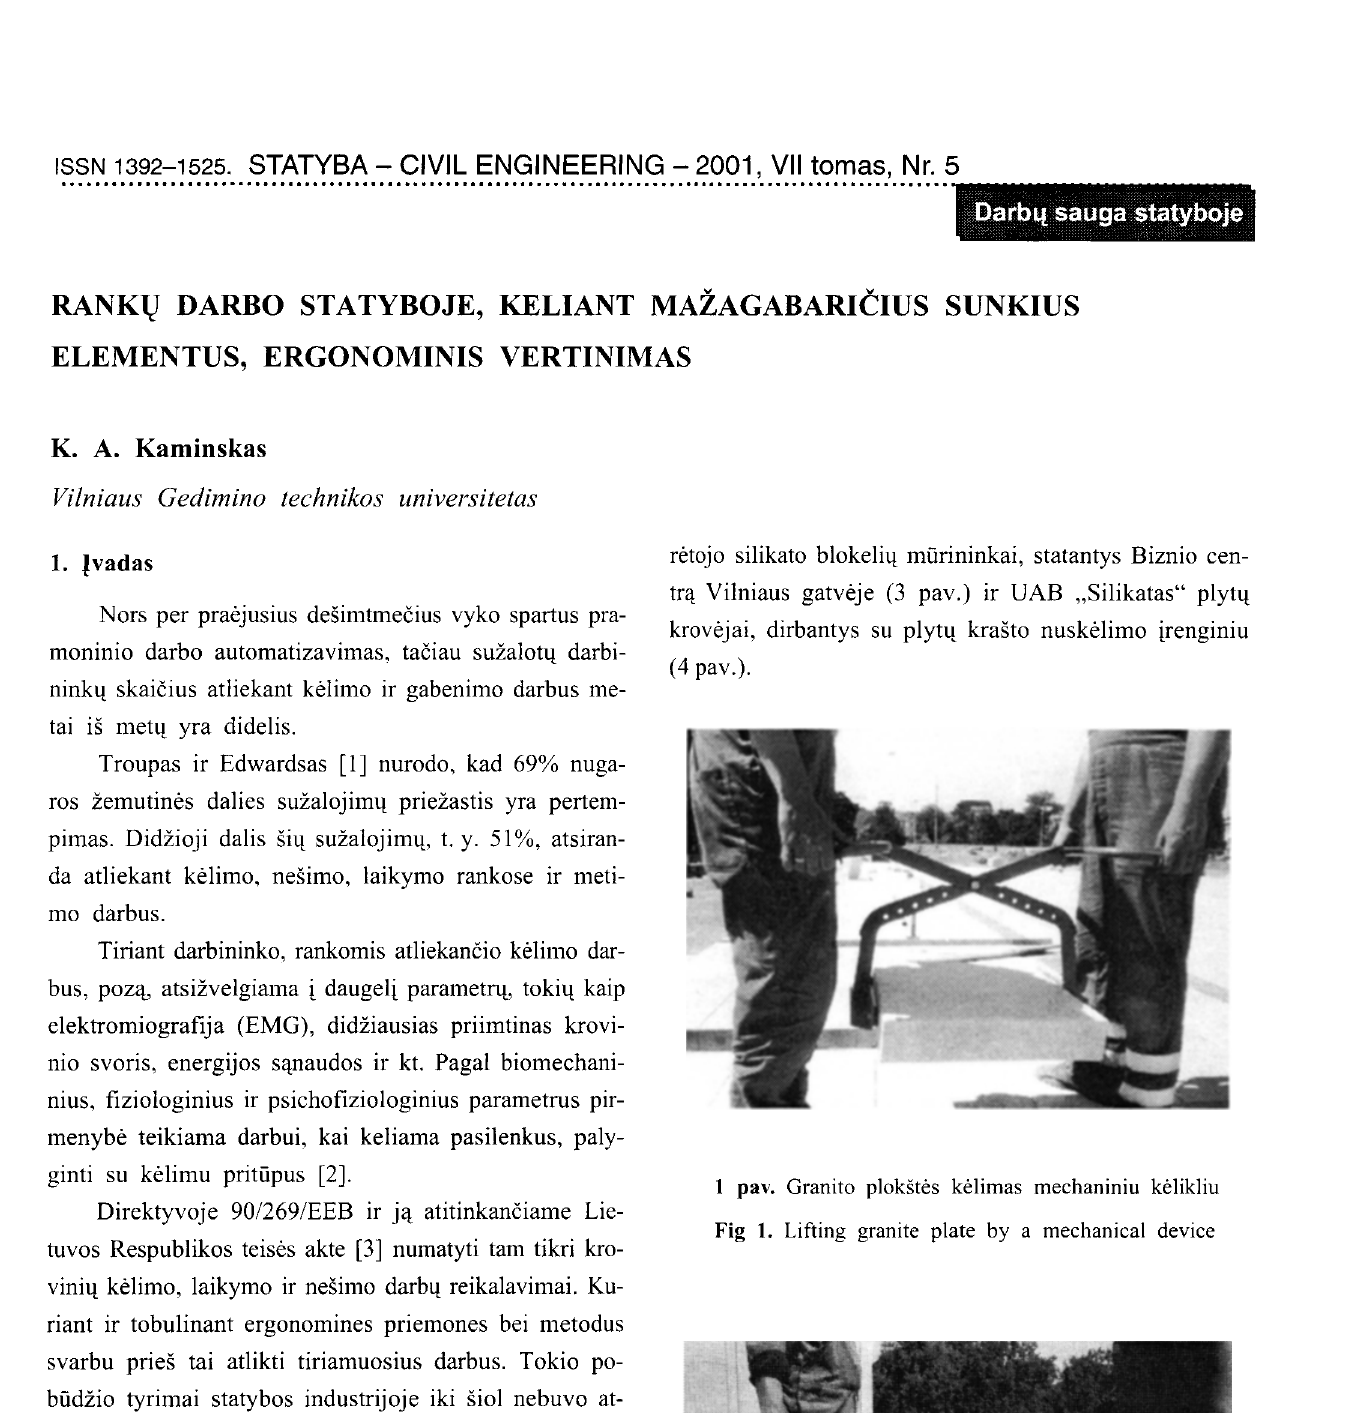
Fig I. Lifting granite plate by a mechanical device